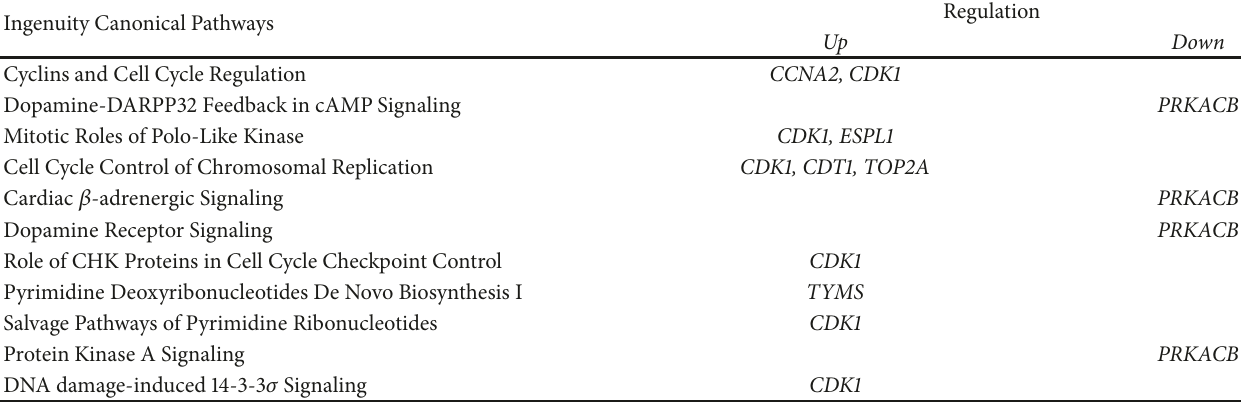
Table 3: Ingenuity Canonical Pathways and the corresponding genes in the transcriptome analysis differentiating malignant PC/PG cases in TCGA and COMETE